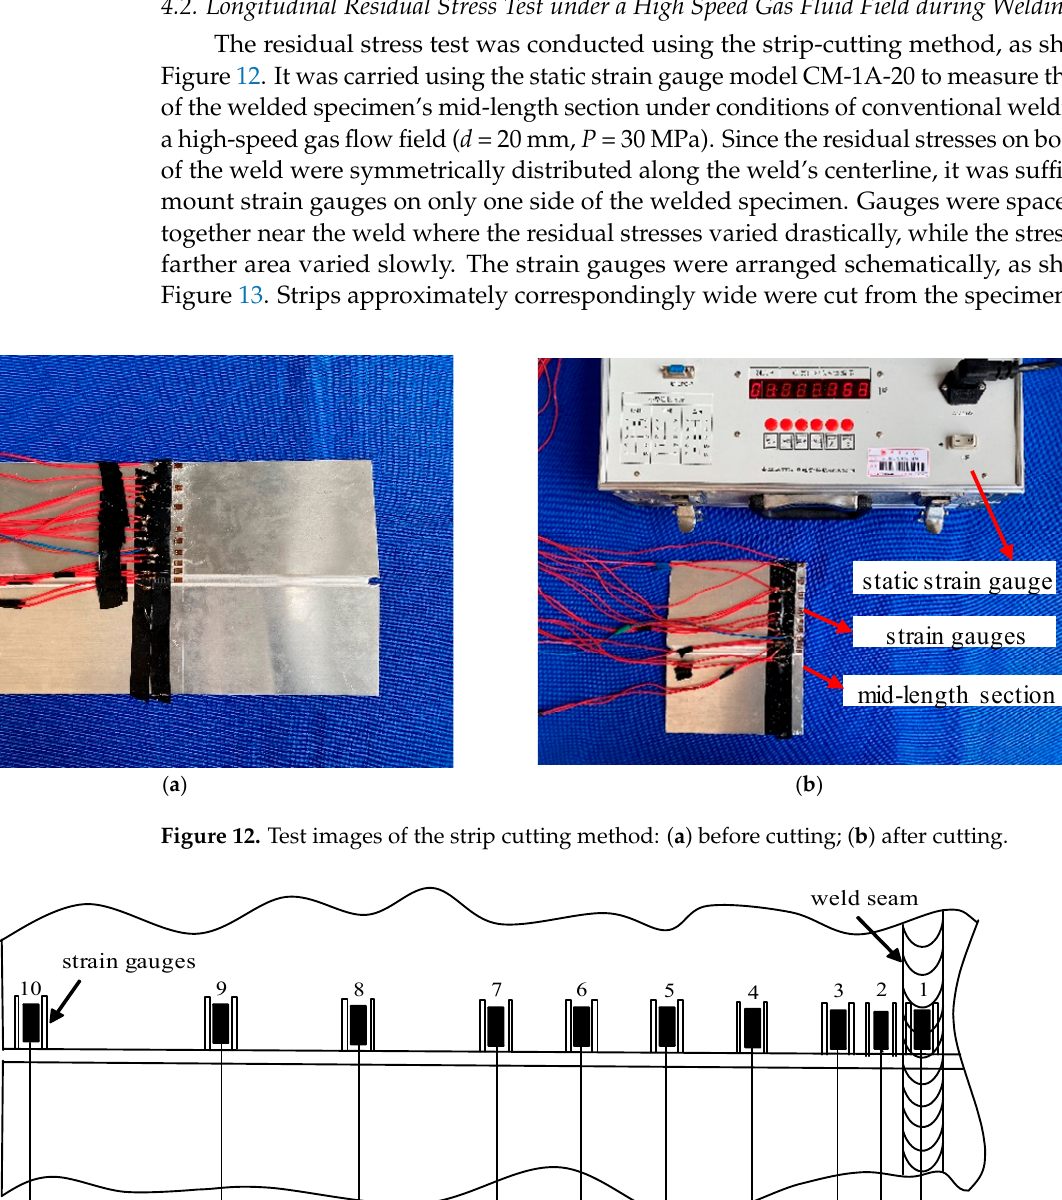
Figure 11. Adjustment range of the loading distance ( d ).